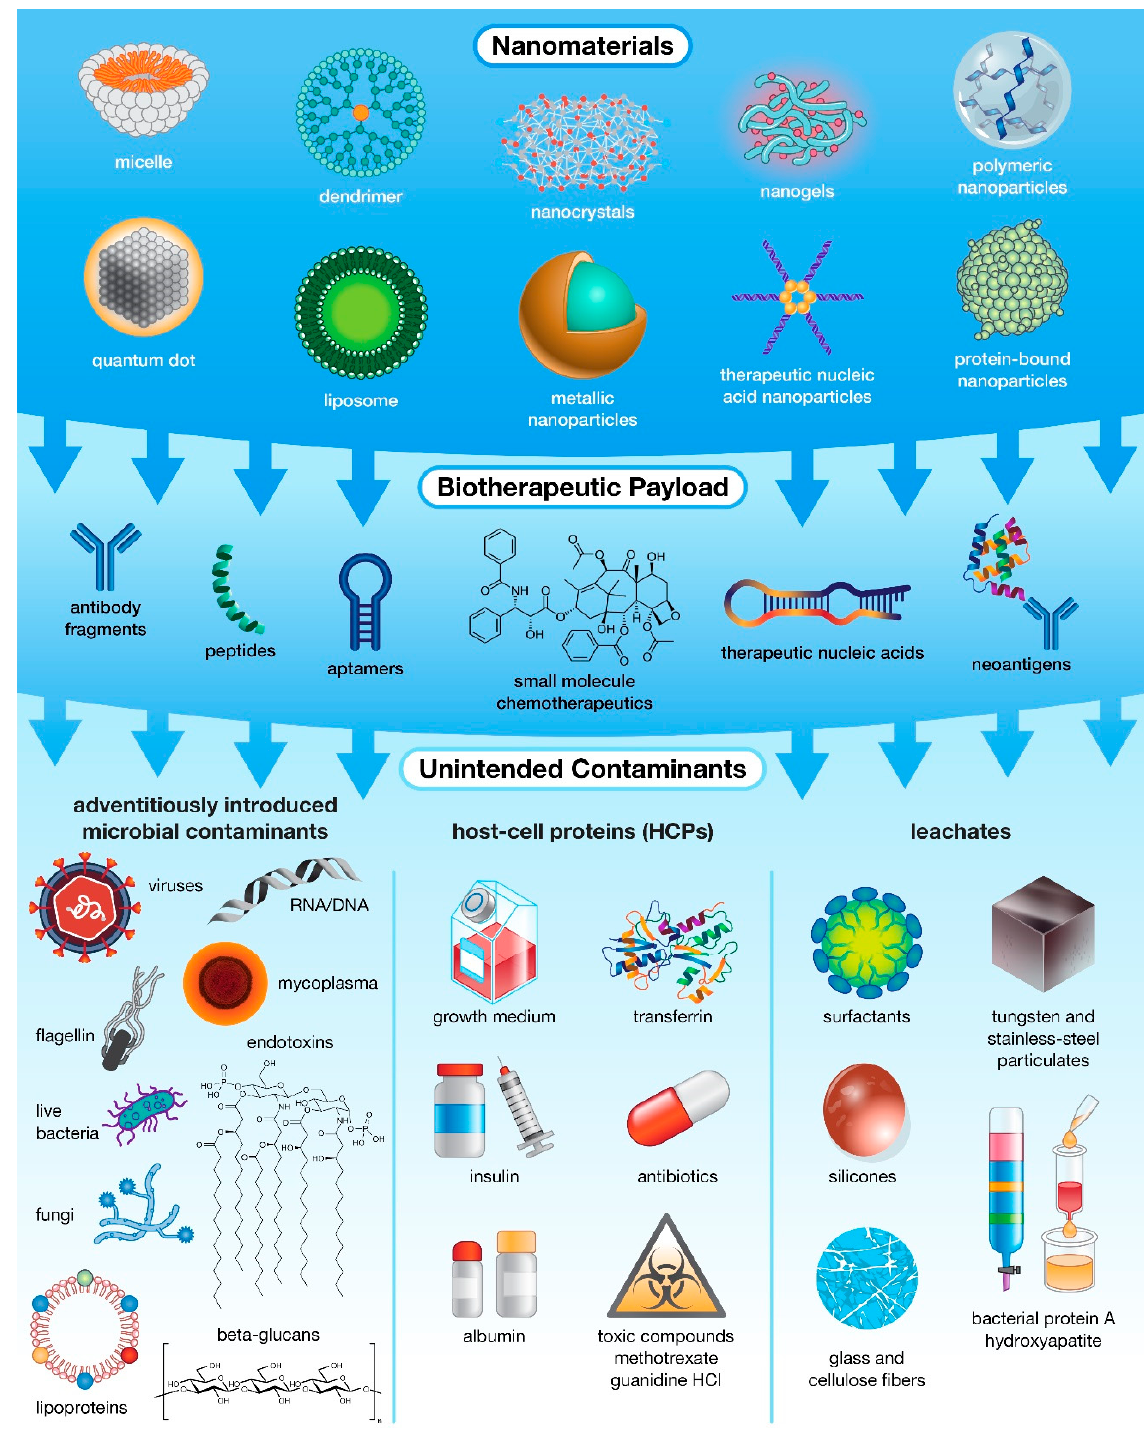
Figure 1. The many levels of possible unintended contamination in drug products. While most often associated with microbial contamination, unintended impurities can actually be introduced into pharmaceutical products from multiple sources, including raw materials and specialized host-cell reagents, and at various stages of production, ranging from fabrication and payload encapsulation in nanocarriers to purification of the final formulation.